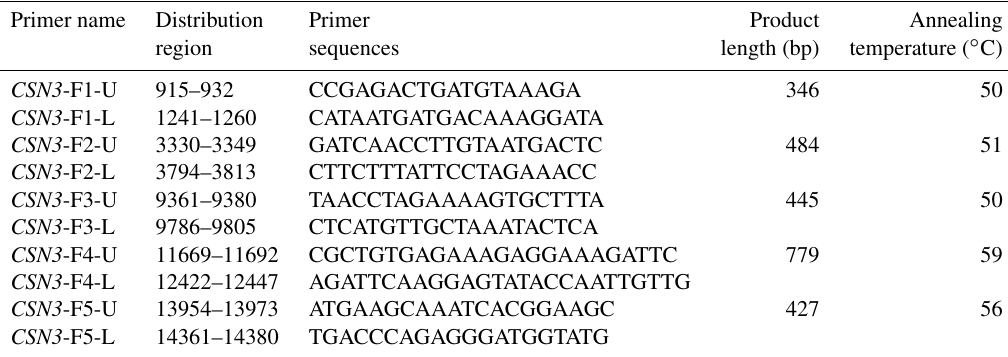
Table 1. Primer information in this